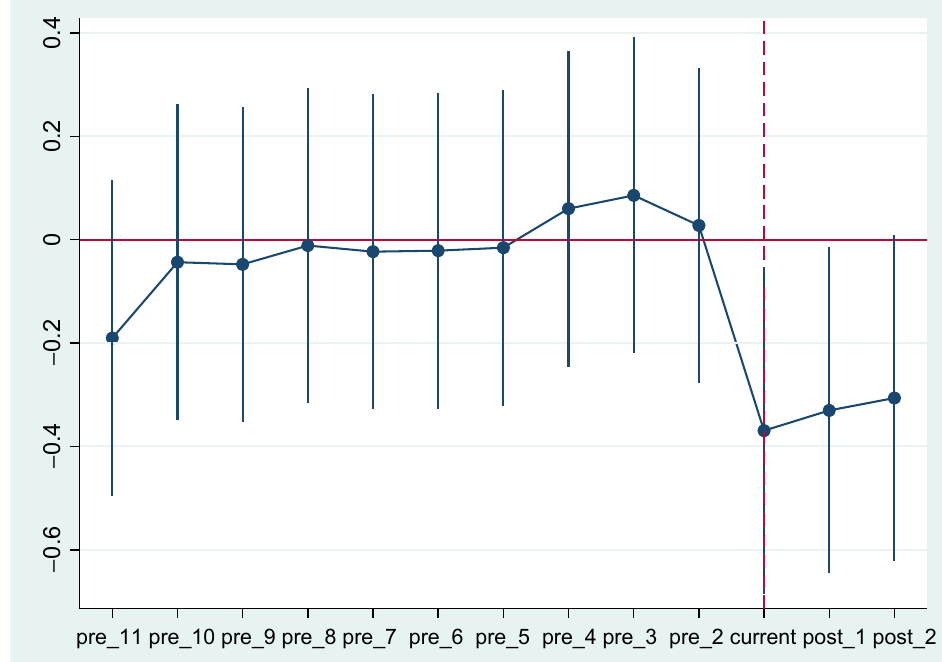
Figure 3. Parallel trend test of emission permit management policies in key polluting industries.